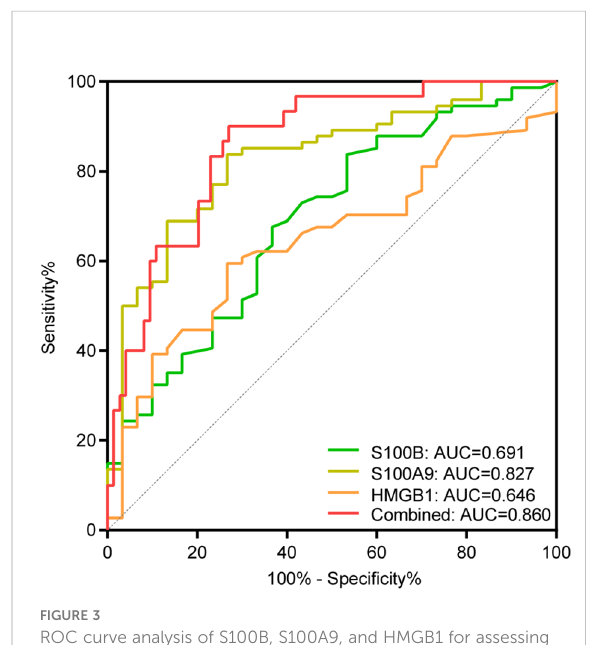
FIGURE 3 ROC curve analysis of S100B, S100A9, and HMGB1 for assessing disease activity. AUC indicates the area under the receiver operating characteristic curve. The green, yellow, and orange curve represents the ROC curve of S100B, S100A9 and HMGB1, respectively; the red curve represents the ROC curve of the combination of S100B, S100A9, and